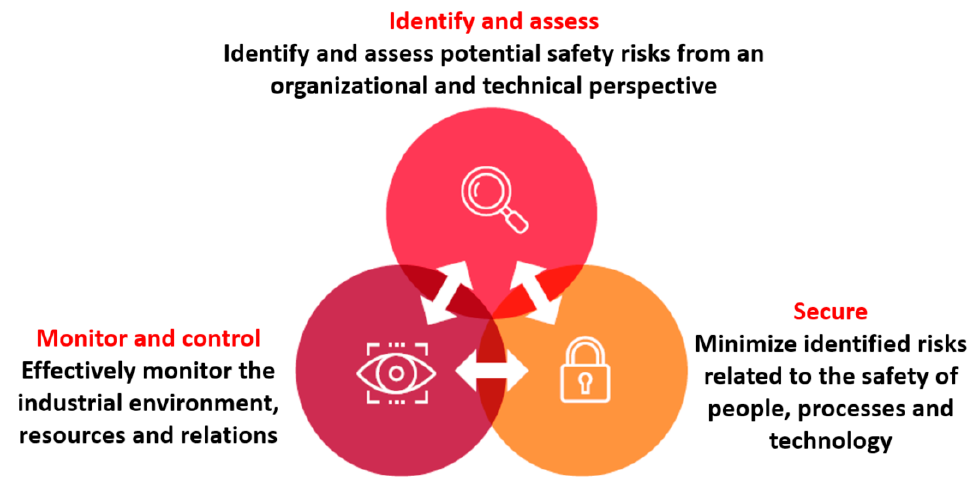
Figure 29. Cyber security in IT and OT. Source: own contribution based on [300].